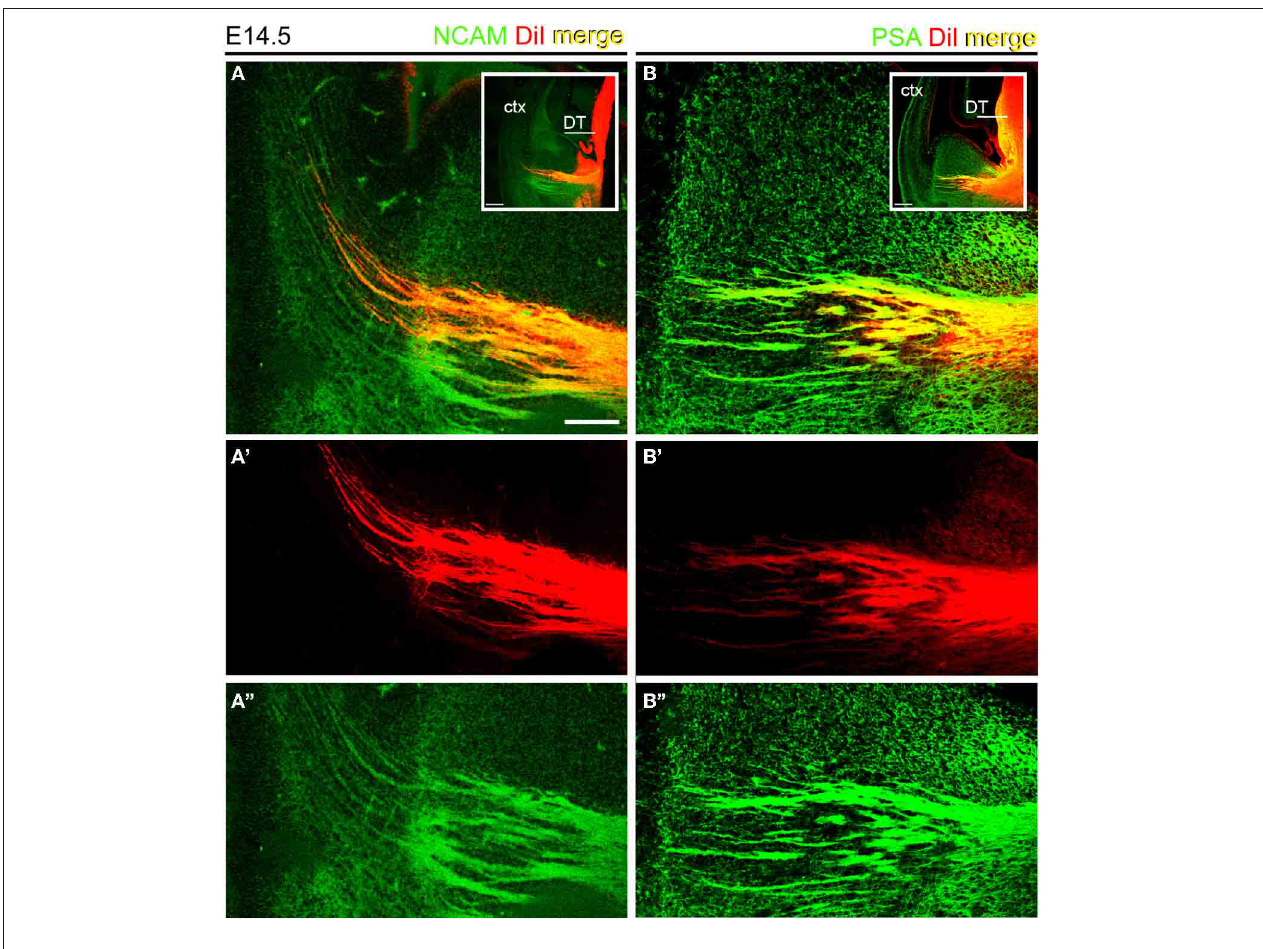
FIGURE 1 | Thalamocortical axons expressed NCAM and PSA at E14.5. Sections containing DiI-labeled TC axons were labeled with antibodies to the intracellular domains of large NCAM isoforms (A) and PSA (B). Insets show the regions analyzed. A’ , A” and B and B” show the detection channels separately. Note that the red signal of